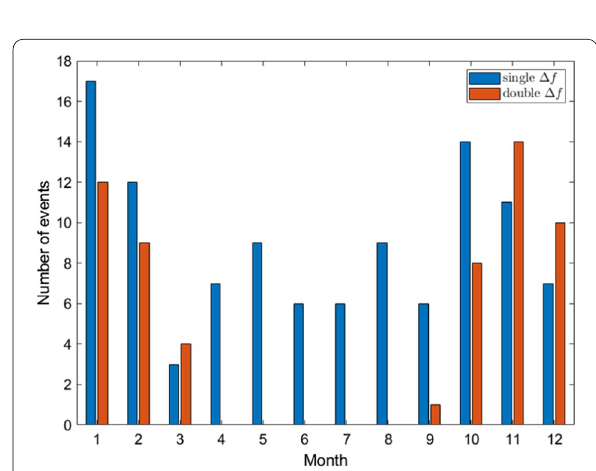
Fig. 6 Seasonal variation of occurrence of IAR with single as well as double Spectral Resonance Structures for the year